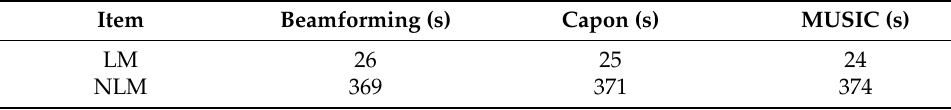
Table 5. Running time of different